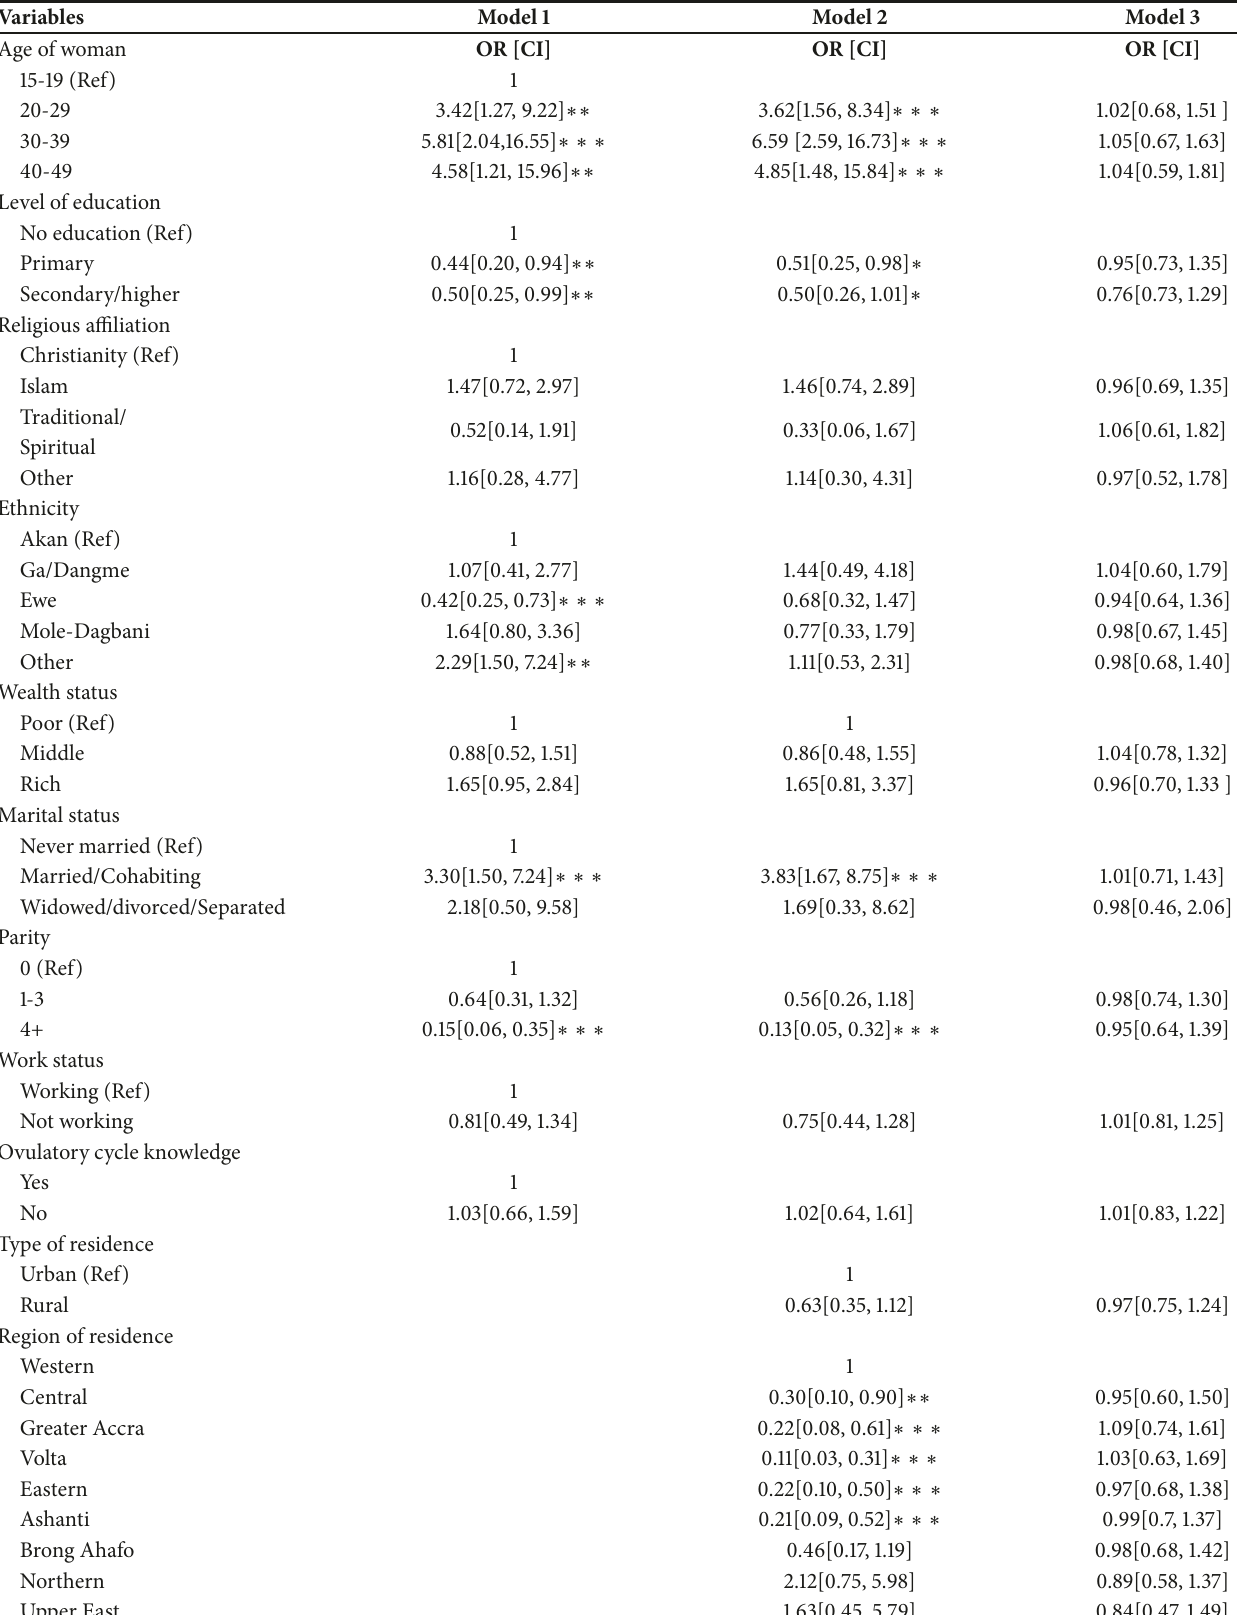
Table 2: Logit regression analysis of unintended pregnancy among pregnant